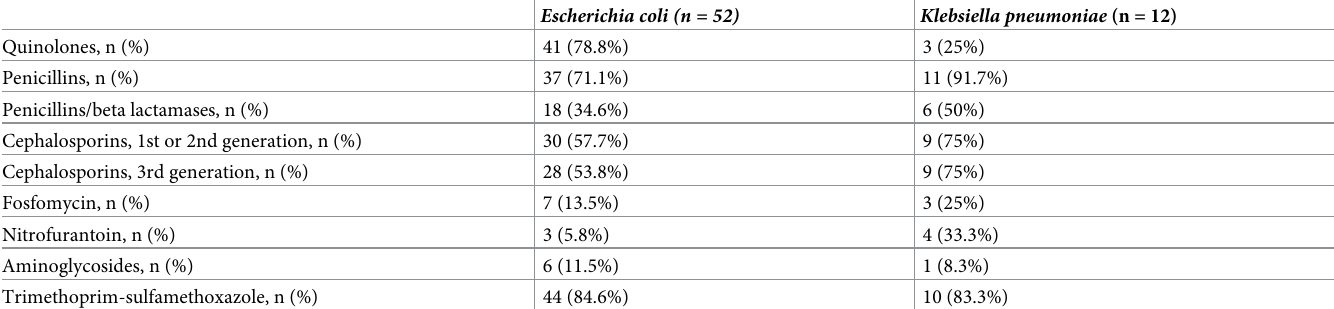
Table 4. Antibiotic resistance patterns of the most common isolated bacteria.